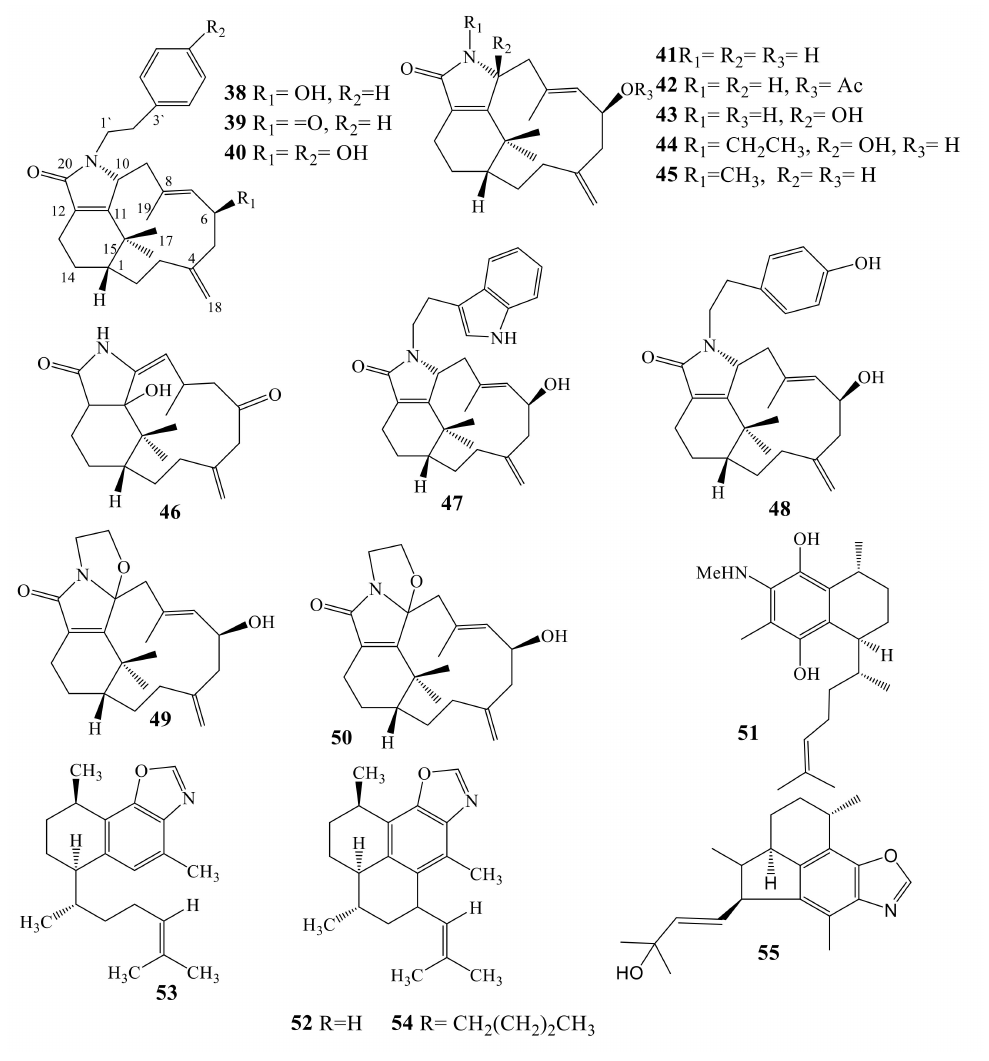
Figure 5. N-Containing diterpenes ( 38 – 55